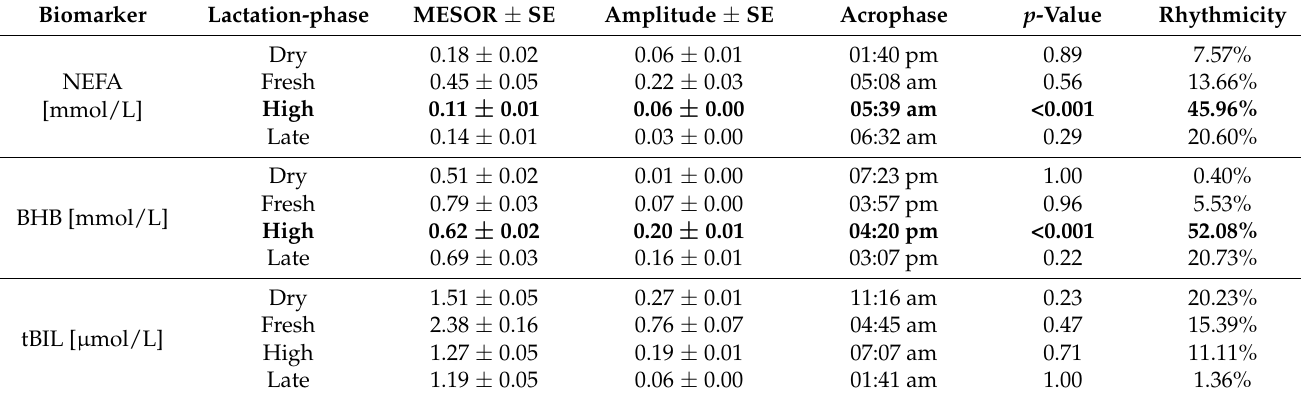
Figure 2. Cosine fits of non-esterified fatty acids (NEFA) and beta-hydroxybutyrate (BHB) for high lactation. Both show a significant circadian rhythm which can be described as a cosine function, (NEFA: p < 0.001, R 2 = 45.96%; BHB: p < 0.001, R 2 = 52.08%). Table 1. Parameters of circadian rhythmicity for non-esterified fatty acids (NEFA), beta-hydroxybutyrate (BHB), and total bilirubin (tBIL). MESOR: Midline Estimating Statistic Of Rhythm or rhythm-adjusted mean. Significant cosine fits are highlighted in